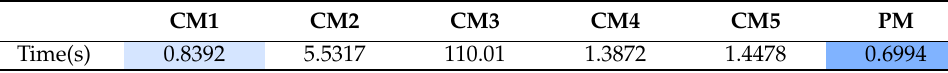
Table 3. Average execution time (s) per